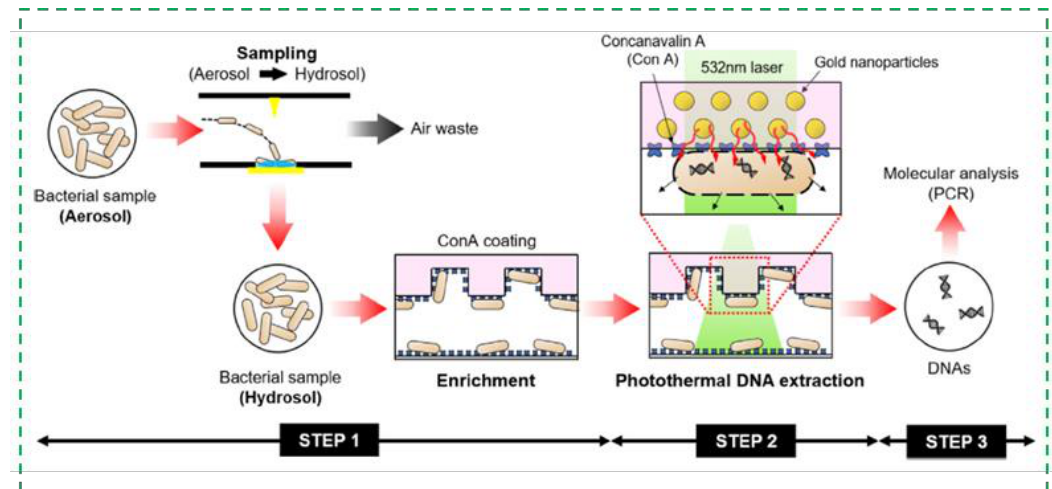
Figure 7. The microfluidic chip for PCR detection of the bacterial bioaerosols. Reprinted with permission from ref. [94]. Copyright 2017 Elsevier B.V.